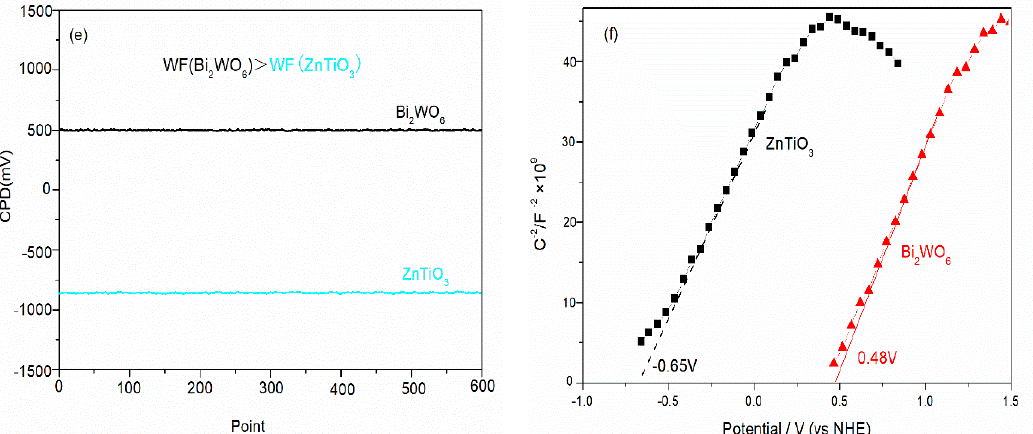
Figure 10. ( a ) UV–vis spectroscopy, ( b ) band gap, ( c ) valence band position, ( d ) PL spectroscopy, and ( e ) work function of the Bi 2 WO 6 , ZnTiO 3 , and Bi 2 WO 6 /ZnTiO 3 catalysts; and ( f ) the flat band potentials according to a Mott–Schottky electrochemistry spectroscopy test.